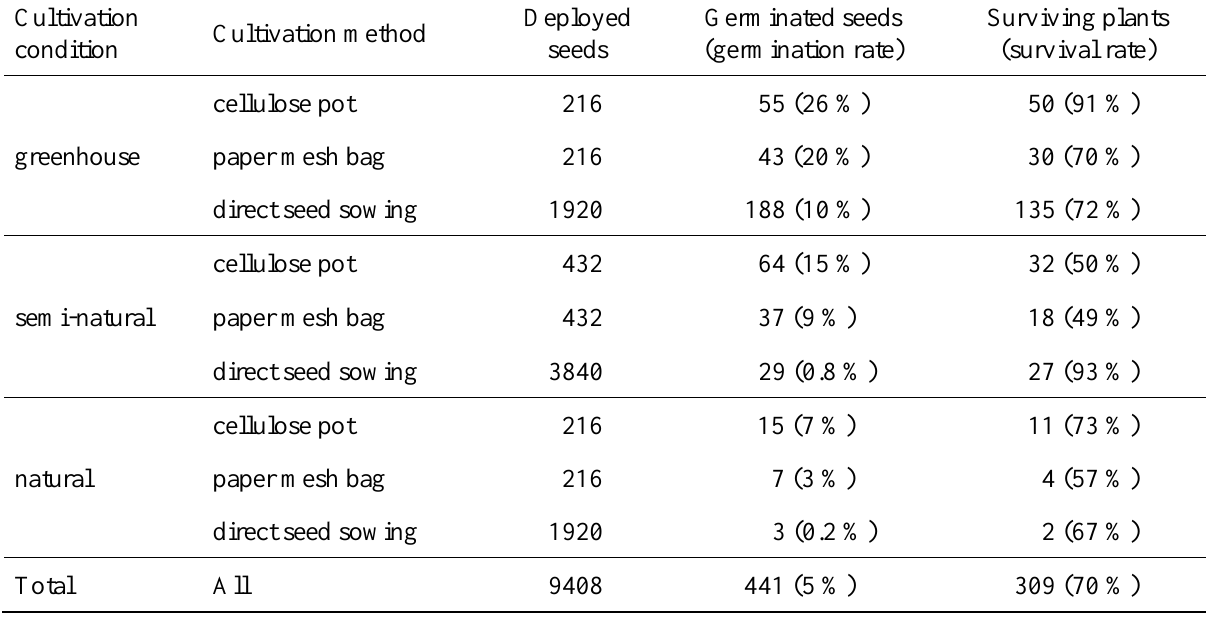
Table 2. Total numbers of deployed and germinated Drosera rotundifolia seeds, germinated seeds and germination rate in the same year, and surviving plants and survival rates in the following year for the various cultivation conditions and methods.